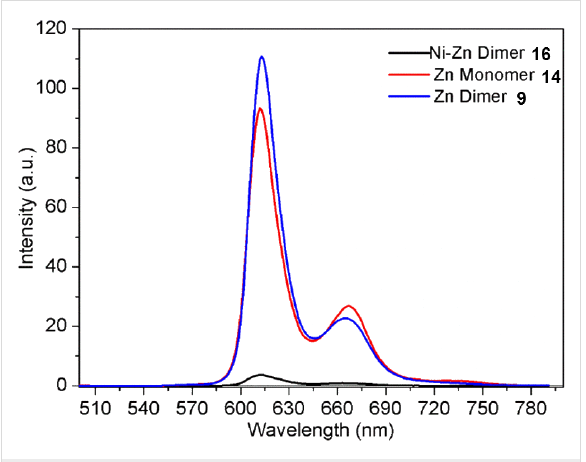
Figure 7: Emission spectrum of symmetric and unsymmetric trip- tycene-linked porphyrin dimers 9 and 16 , and a triptycene-linked porphyrin monomer 14 in CHCl 3 (all compounds were excited at λ = 430 nm).